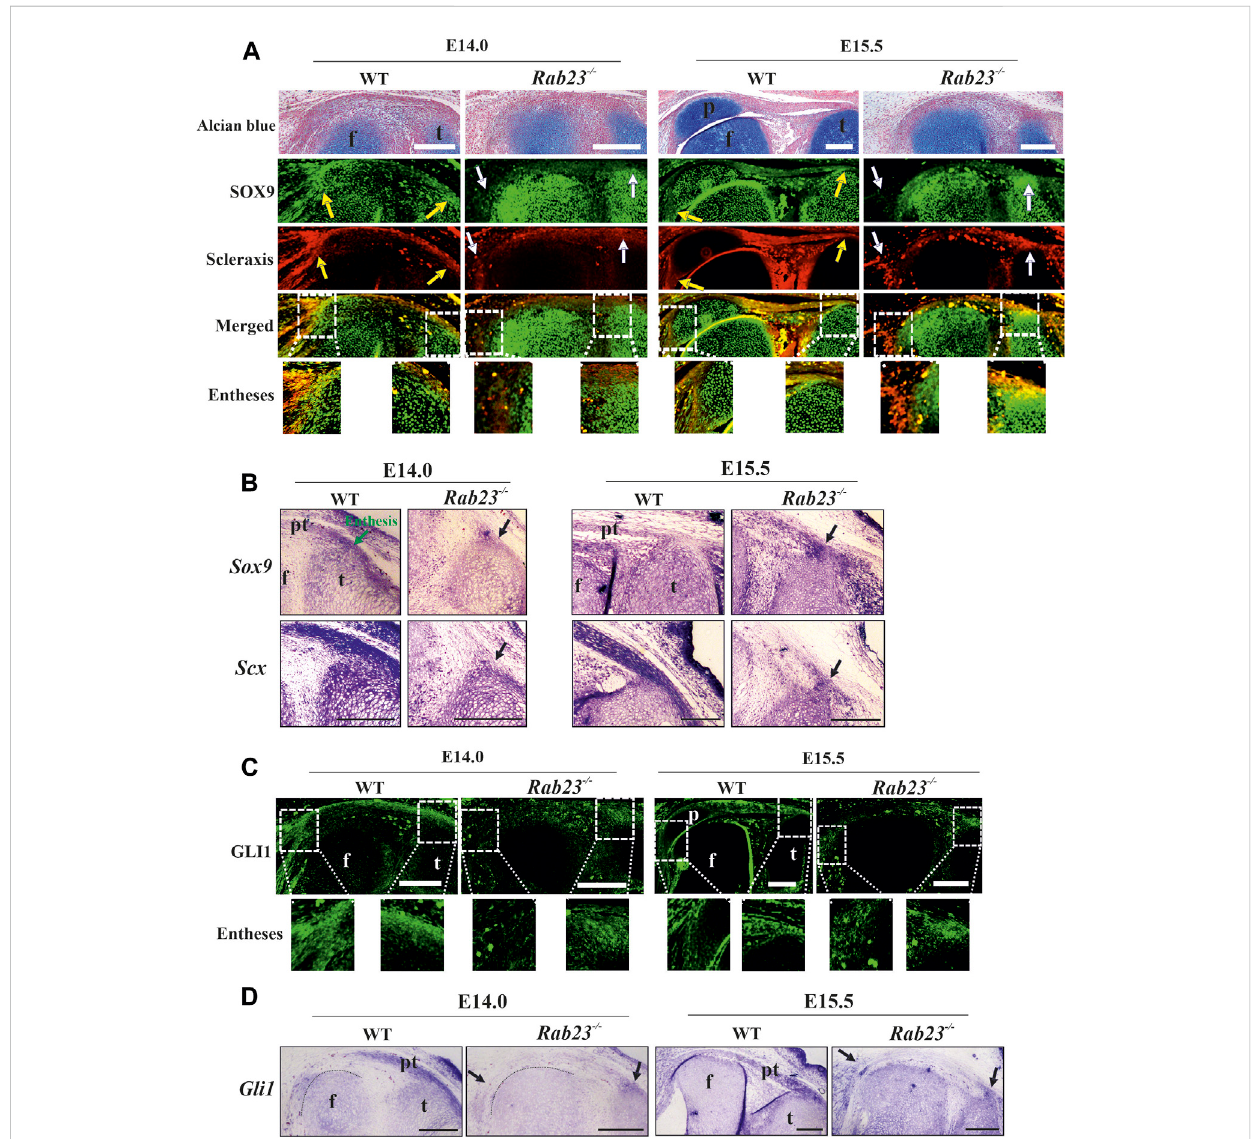
FIGURE 4 Scleraxis,SOX9,andGLI1expressionanalysisduringenthesisformation. (A,B) Immunohistochemicaland insitu expressionanalysisofSOX9andScx in the Wt and Rab23 − / − mice sagittal sections of the hind limbs obtained from E14.0 and E15.5 embryos. In Wt samples, both these markers are predominantly co-expressed in the junction between the quadriceps tendon and the patella (yellow arrow) (A) and also the patella tendon and the tibia (yellow and black arrows) at both the embryonic stages (A, B) . In Rab23 − / − samples, since no patella was formed, co-expression of SOX9 and Scx is missing (white arrows) (A) except that the junction between the patella tendon-like structure and tibia gives rise to malformed entheses at E15.5 (white andblackarrows) (A,B) .Tohighlightthecartilagecellsofthepatella,sagittalsectionsfromE14.0andE15.5hindlimbsarestainedwithAlcianblueandfast red (upper panel) ( n = 3 samples for each age and genotype). p: patella, pt: patellar tendon, f: femur, and t: tibia. Scale bar: 200 μ m. (C, D) Immunohistochemical and in situ expression analysis of Hh (Hedgehog) component Gli1 in the Wt and Rab23 − / − mice sagittal-sectional tissues of hind limbsareobtainedfromE14.0andE15.5embryos.InWtsamples,Gli1ispredominantlyexpressedinthefuturepatella,patellatendon,quadricepstendon, rectus femoris, and vastus medialis tendon and in the meniscus at both the embryonic stages (C, D) . In Rab23 − / − samples, Gli1 is weakly expressed throughouttheE14.0andE15.5tissuesandgivesrisetothemalformedentheses(blackarrows) (C,D) .Blackdottedmarkingindicatestheendofthefemur toward the patella (D) ( n = 3 samples for each age and genotype). p: patella, pt: patellar tendon, f: femur, and t: tibia. Scale bar: 200 μ